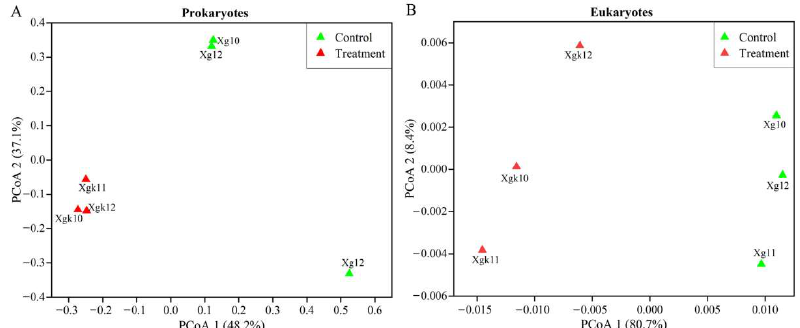
Figure 2. Principal coordinates analysis of the larval microbial communities. PCoA of prokaryotic ( A ) and eukaryotic ( B ) communities by treatment based on Bray–Curtis distance dissimilarities. Each point corresponds to a sample and the letters above the points indicate sample names. Control and treatment groups are shown in different colors.